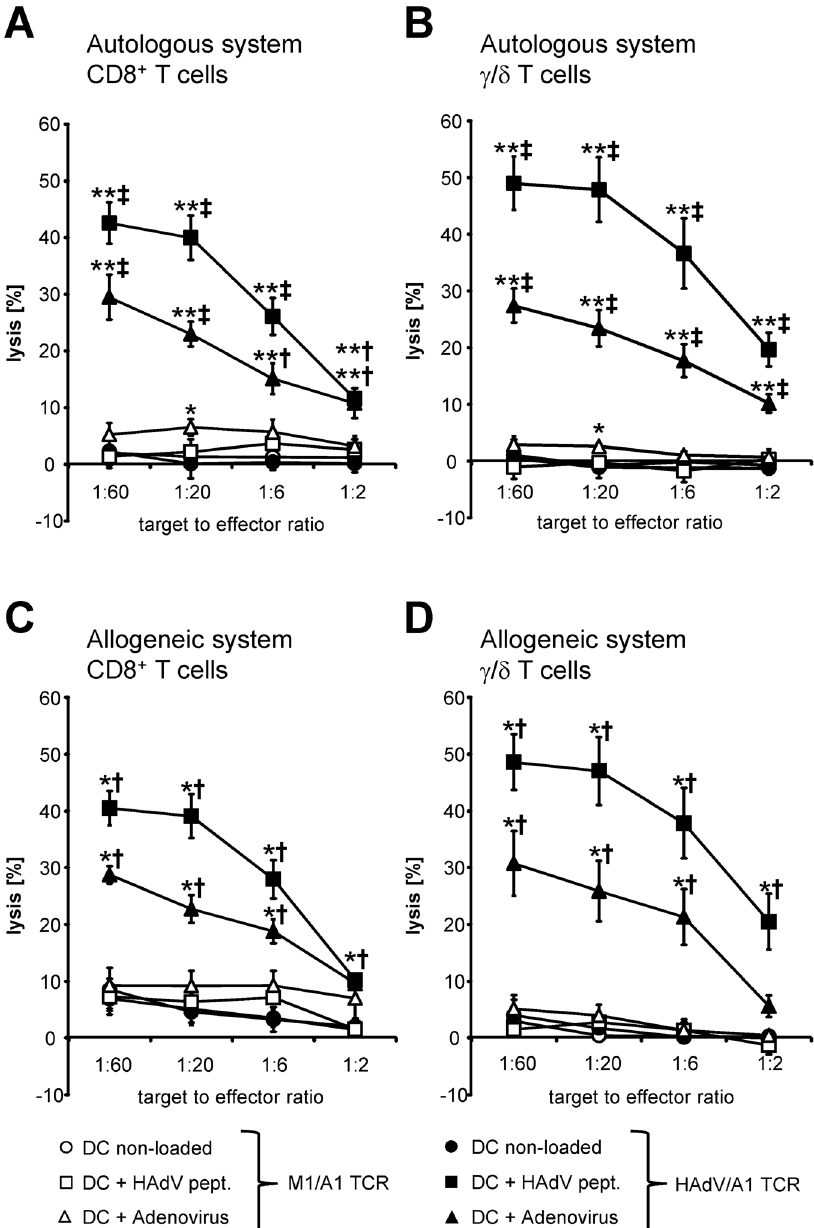
Figure 7. Cytolytic capacity of HAdV/A1-TCR-transfected CD8 + T cells and c / d T cells against adenovirus-infected target cells. CD8 + T cells ( A and C ) and c / d T cells ( B and D ) of the same donors were either electroporated with mRNA encoding the MAGE-1/A1-specific TCR (open symbols) or electroporated with mRNA encoding the HAdV/A1-specific TCR (closed symbols) either in combination with CD8 a mRNA ( c / d T cells) or not (CD8 + T cells). These cells were used as effector cells in standard 4–6 h cytotoxicity assays. Autologous ( A and B ) and allogenic ( C and D ) DC either untreated (non-loaded), loaded with the adenovirus peptide (Adeno pept.), or infected with adenovirus (adenovirus) were used as target cells and the percentage of lysed cells was calculated. The target to effector cell ratios were 1:60, 1:20, 1:6, and 1:2. Average values of 6 ( A and B ) or 4 ( C and D ) individual experiments (each performed in triplicates) + / 2 SEM are shown. P-values were calculated by the Mann-Whitney U test. For statistics, conditions were compared to the non-loaded DC condition (* and **) and to T cells transfected with the M1/A1 control TCR ( ` and { ). (** or ` p # 0.01; *or { p # 0.05). Raw data are summarized in Table S7A to D in File S1.